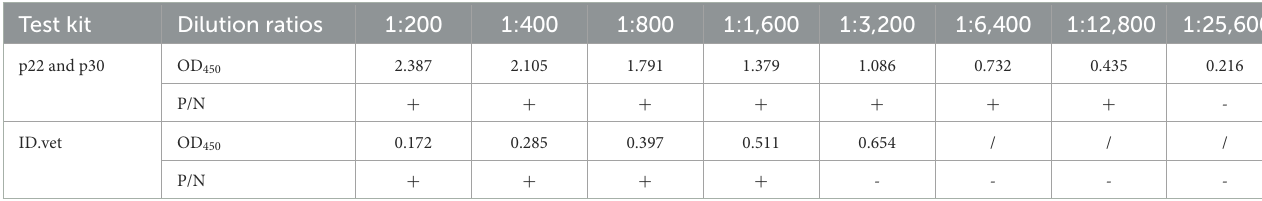
TABLE 3 Determination of